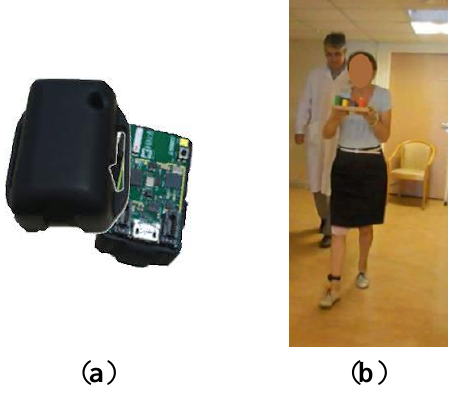
Figure 1. ( a ) FOX node: wireless inertial measurement unit. ( b ) Patient equipped with the sensor.